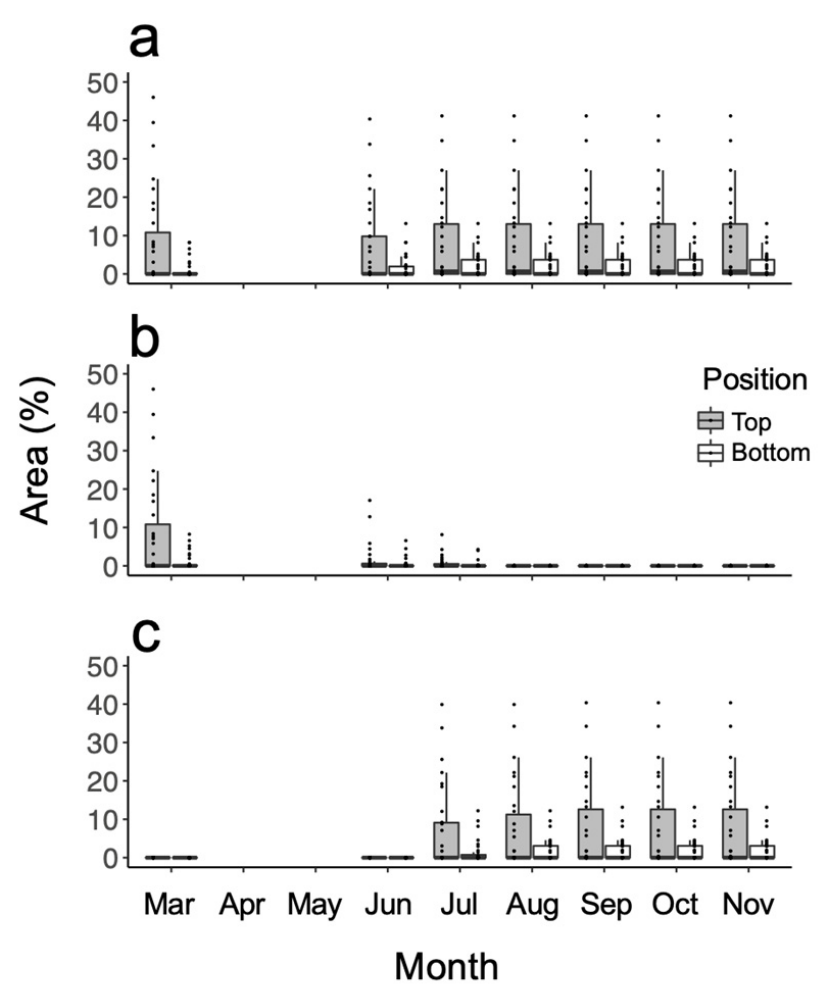
Figure 2. Percentage area of debarked ( a ), anamorph ( b ), and teleomorph ( c ) of Bisogniauxia spp. on Quercus serrata logs. Grey and white bars show the top and bottom sides of the logs, respectively.